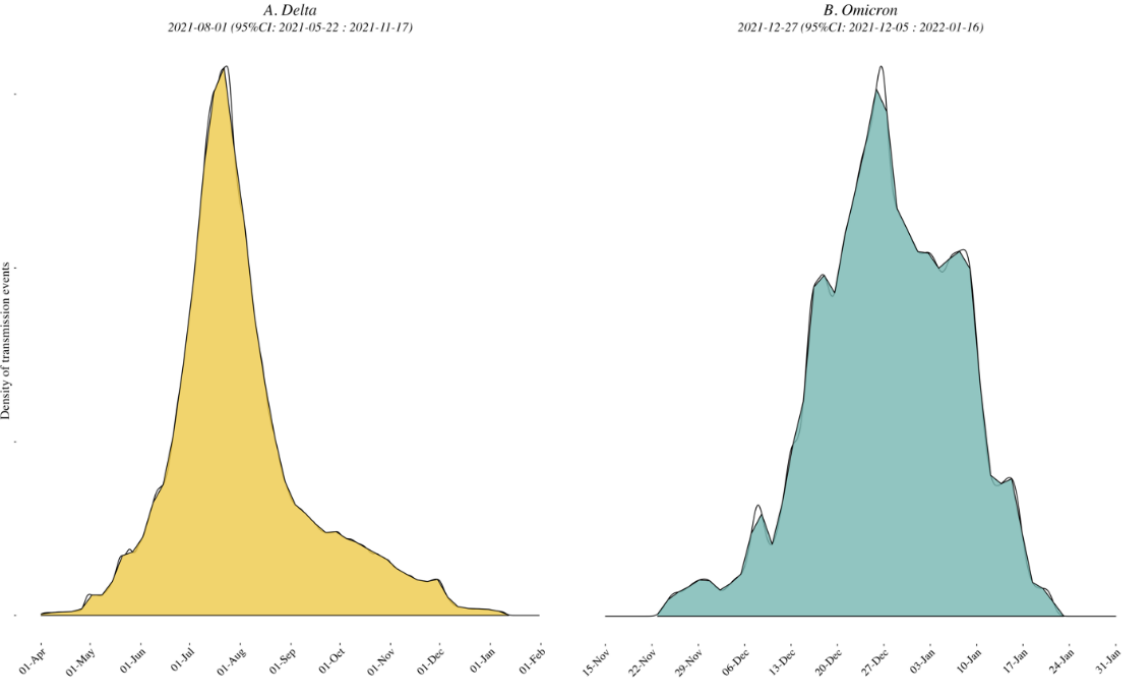
Figure 5. Probability density of variant migration events between locations for Delta ( A ) and Omicron ( B ) variants. Only migration events supported with an adjusted Bayes Factor ≥ 3 are considered. See also Supplementary Figure S8 for results of each of the 10 individual replicates.